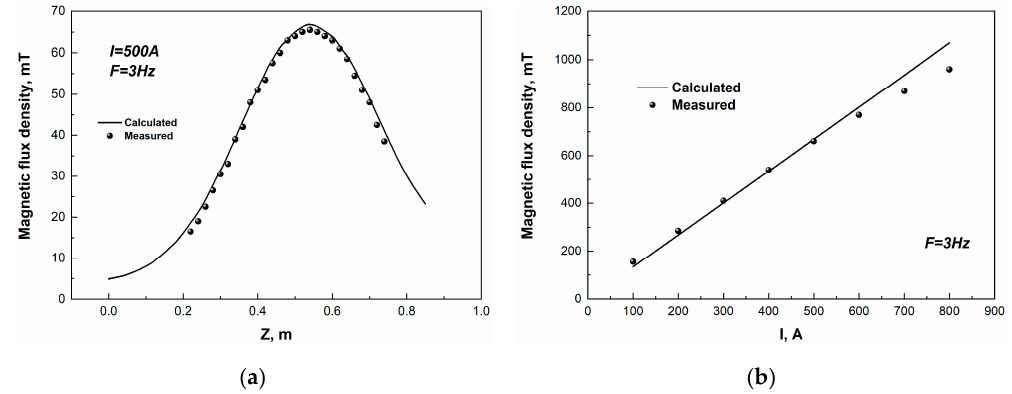
Figure 4. Comparison between calculated and measured data of the magnetic flux density: ( a ) along the centerline of mold; ( b ) in the stirrer center.